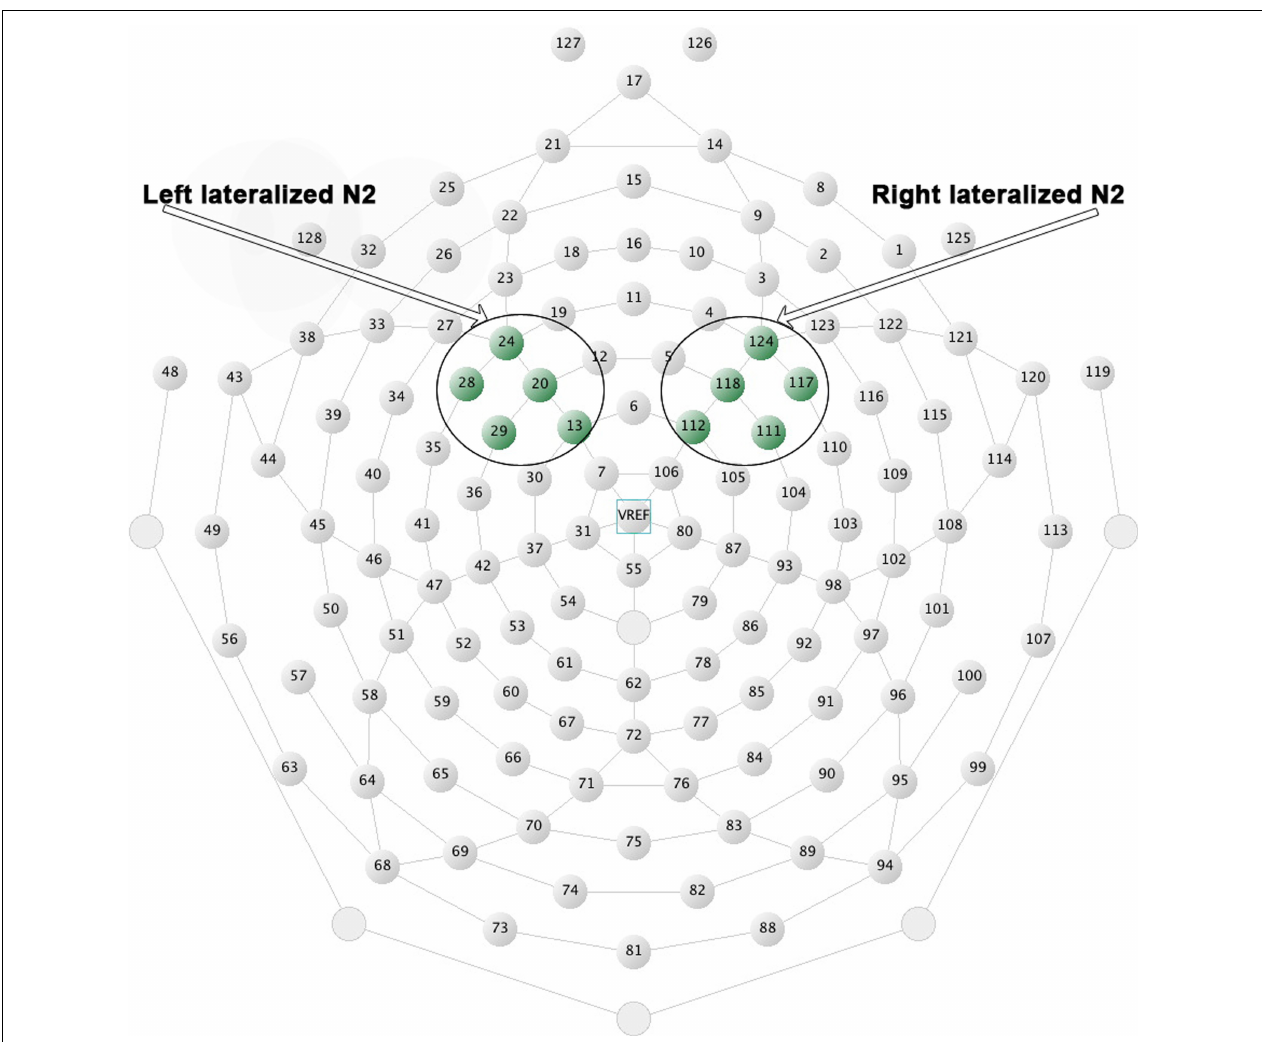
FIGURE 2 | Hydrocel electrode sites contributing to right- and left-lateralized N2 waveforms and